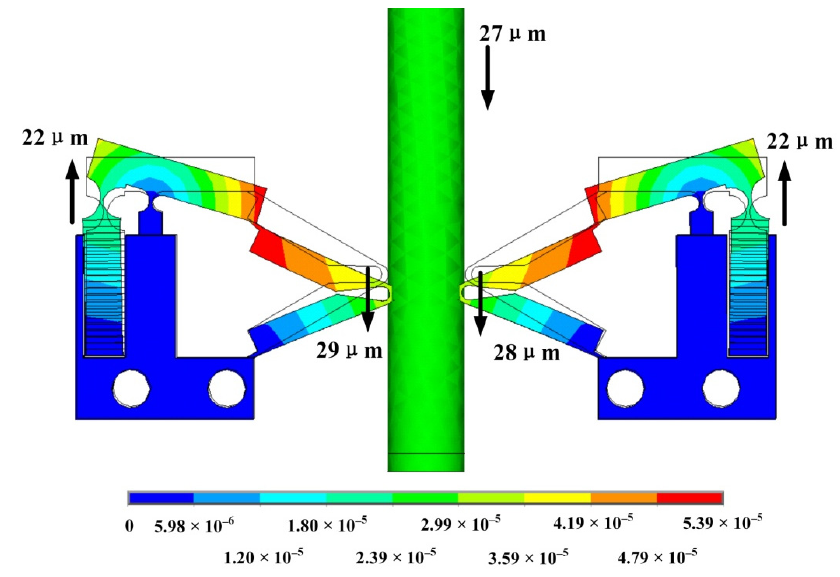
Figure 15. ThePEA deformation under maximum driving.